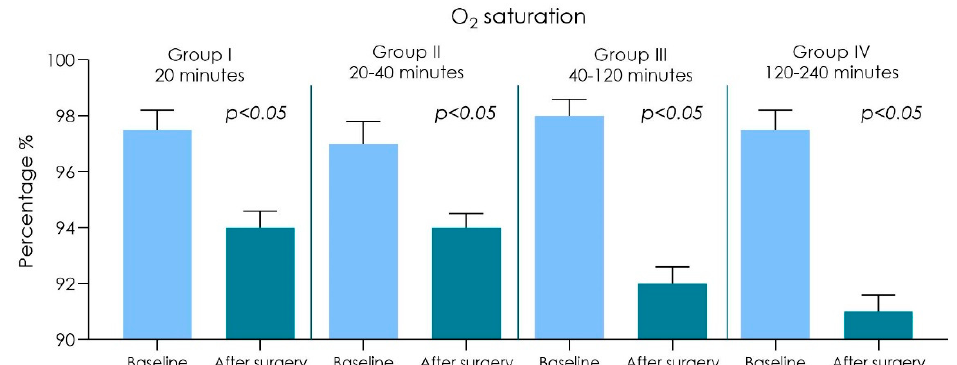
Figure 1. Graph chart of the surgeons O 2 saturation (%) of Group I (20 min), II (20–40 min), III (40–120 min) and IV (120–240 min) (ANOVA post hoc Tukey HSD). No differences were detected between the baseline for both of Group I, II, III and IV. A statistically significant difference was detected in all comparisons after the surgery procedure ( p < 0.05).